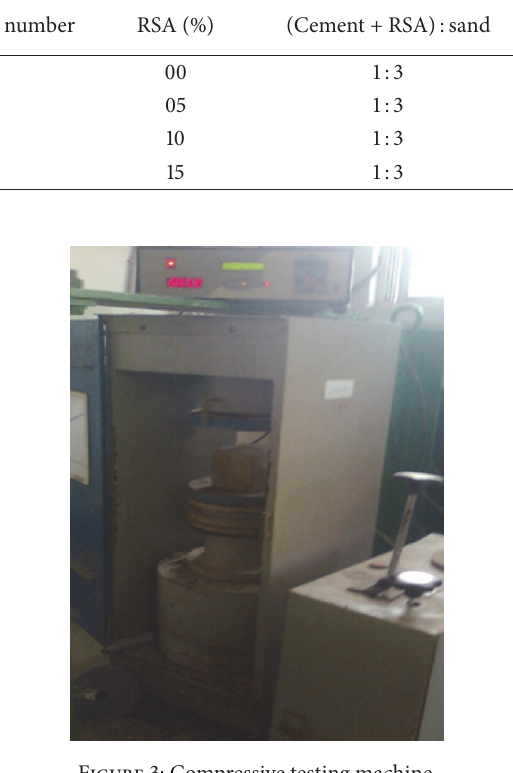
Figure 3: Compressive testing machine.